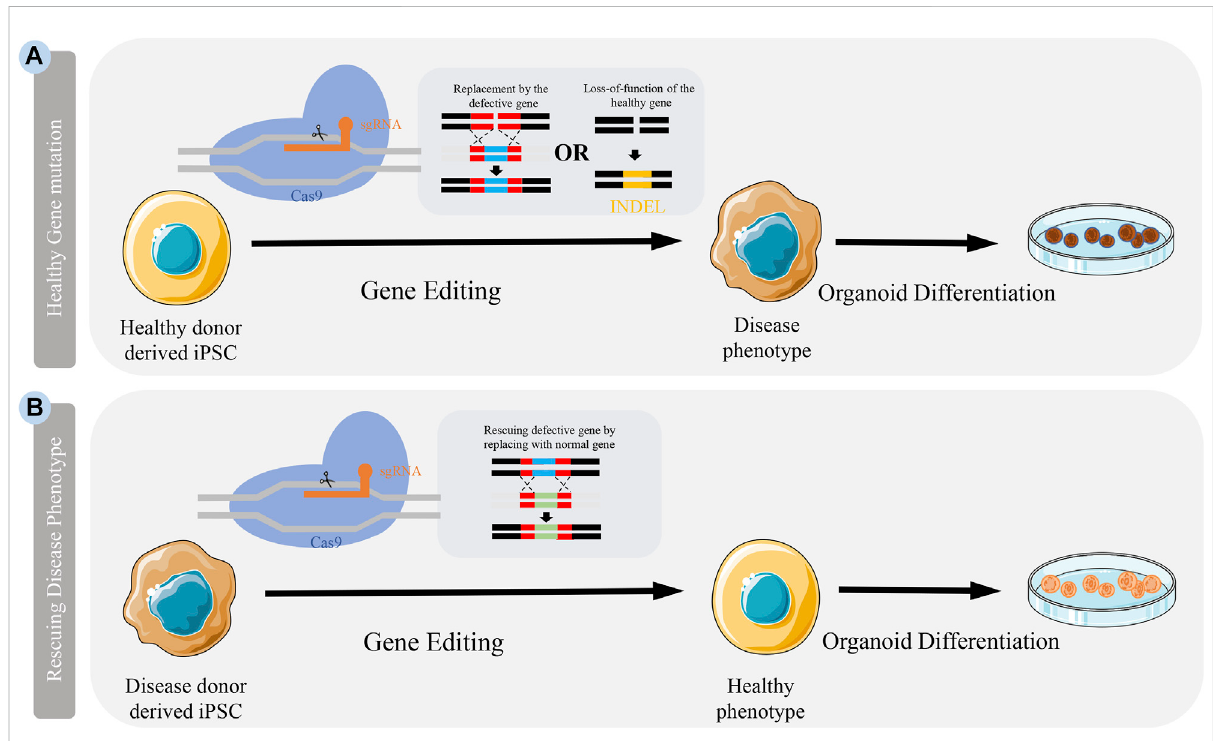
FIGURE 1 Application CRISPR-Cas9 to generate disease model. Models can be generated by either knocking out a healthy gene or rescuing a defective gene incells. (A) Somatic cells from healthypeople arereprogrammed into iPSCs. Speci fi cdisease-causingmutations canbe introduced to